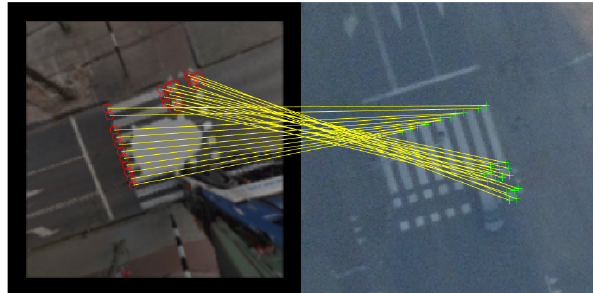
Figure 9. Test area 2; Successful registration also in areas of contrast and illumination differences